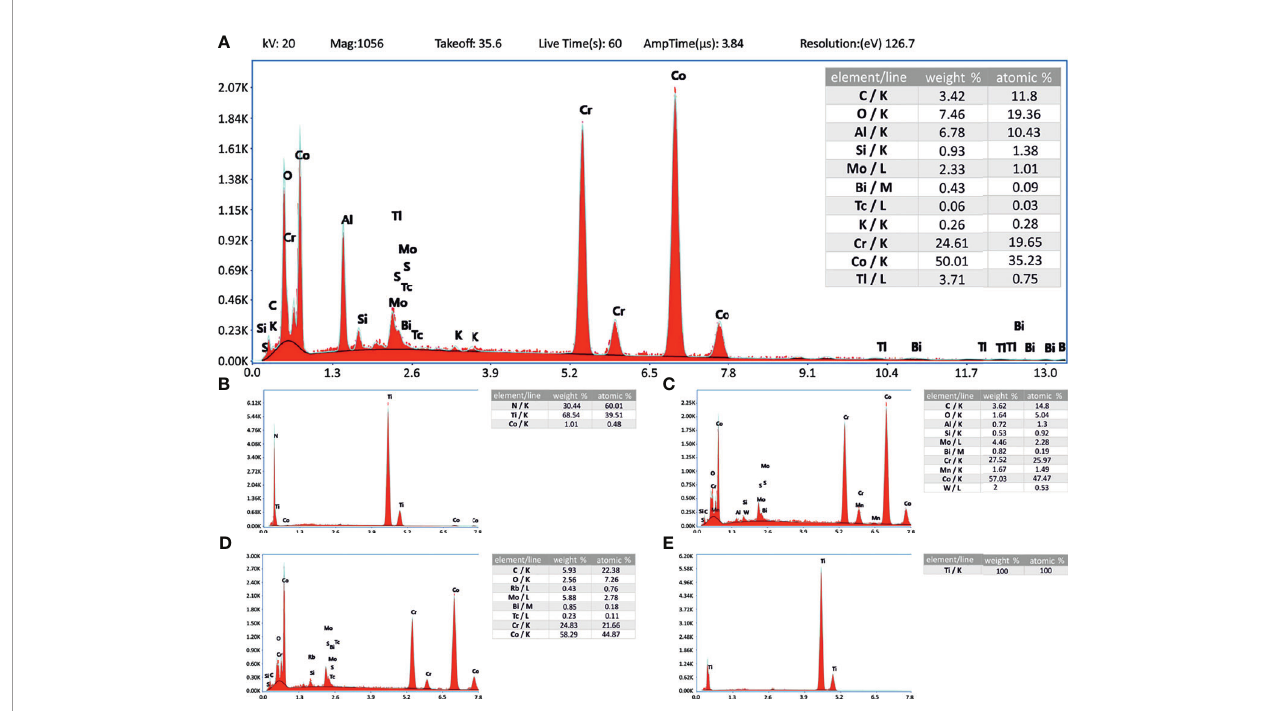
FIGURE 3 | Energy-dispersive X-ray analysis. Inlay tables showing the elemental composition related to the energy level (K-, L- and M-line). Instrument values are given in panel (A) and apply also to (B – E) . (A) CoCrMo; (B) CoCrMo TiN; (C) CoCrMo polished; (D) CoCrMo porous coated; (E) CoCrMo cpTi.